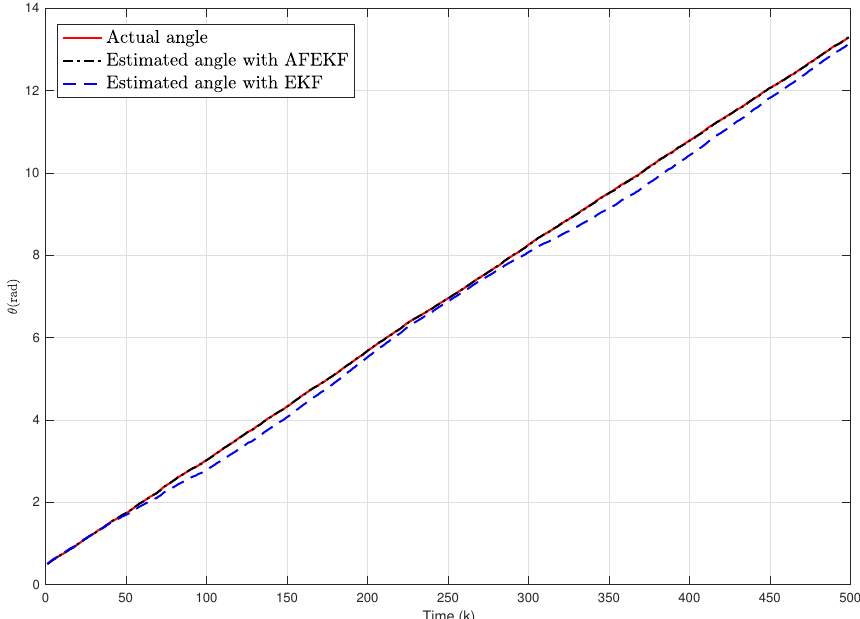
Figure 3. Robot’s angle and its estimates under constant bias.